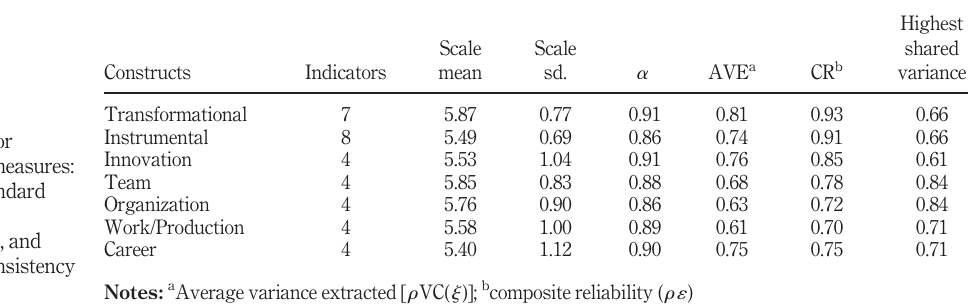
Table I. Statistics for construct measures: means, standard deviations, reliabilities, and internal